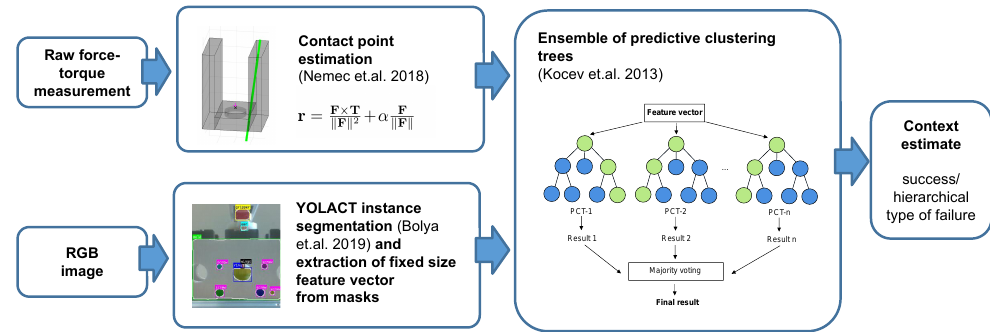
Figure 2. Context determination pipeline. Features are processed for each modality separately (Sections 3.4–3.6) and later merged by using ensembles of predictive clustering trees (Section 3.7). References: